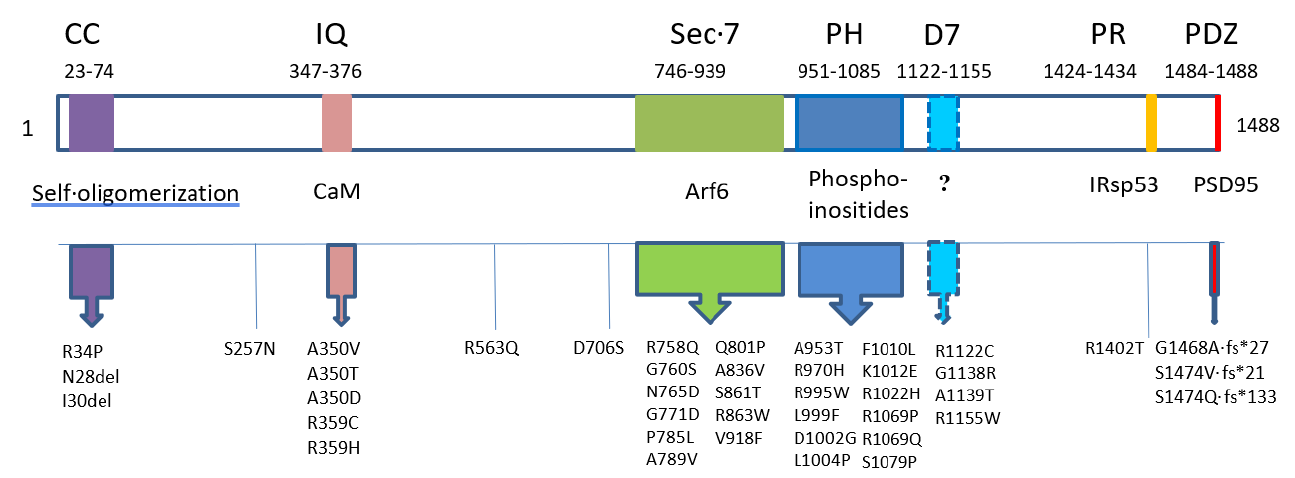
Figure 1. Mutations affecting specific functional domains in IQSEC2. The 1488 aa isoform of the IQSEC2 protein is shown as an elongated rectangle. Functional domains (colored regions) are listed on top of the diagram with amino acid boundaries indicated underneath. They are coiled-coil (CC), IQ-like (IQ), Sec7, pleckstrin homology (PH), proline-rich (PR), PDZ binding motif (PDZ), and a potentially new 7th domain (D7). Domain-binding entities are listed below the diagram. Missense mutations, in-frame deletions (del), and frameshift mutations creating a termination codon (fs*) are listed underneath the relevant domains. R1402 [18] is in close proximity to and likely affects the PR domain. R1122C [15], G1138 [16], A1139 [14], and R1155W [14] define domain D7. S257N [19], R563Q [17], and D706S [16] do not fall in any previously described domain and their mode of pathogenicity is not known. One possibility is that they disrupt the allosteric influence of the IQ domain on Sec7 activity.